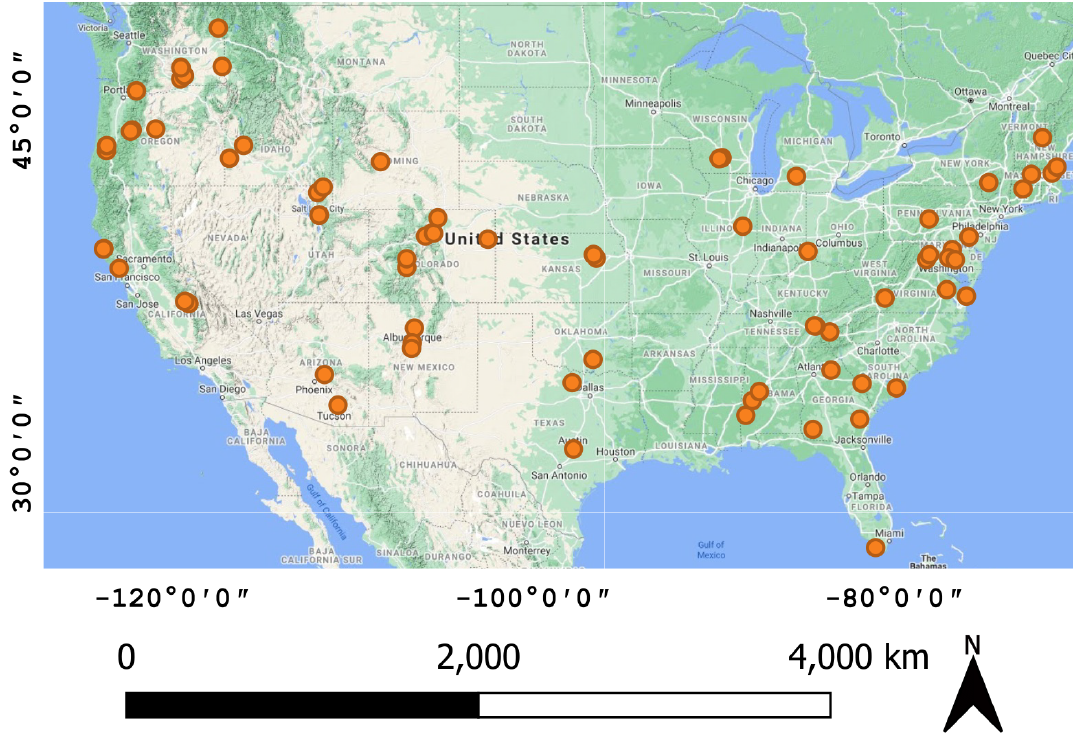
Figure 1. Map of sampling locations distributed across the contiguous United States (ConUS). Surface water and sediments were collected at each site using a crowdsourced approach via the WHONDRS consortium. Physical factors such as stream order were not constrained. Figure generated by Sophia McKever using QGIS. The base map is copyrighted: ©OpenStreetMap contributors 2022. Distributed under the Open Data Commons Open Database 504 License (ODbL)